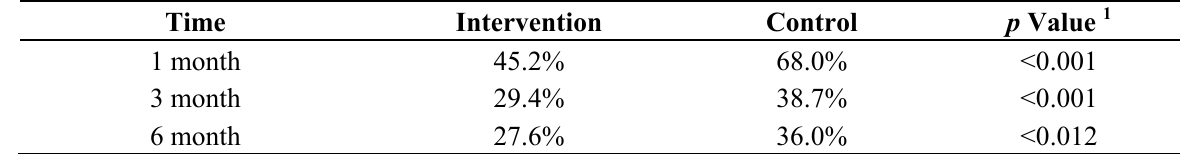
Table 4. Percentage of women reporting 1 or more side effects at 1, 3, 6 months.